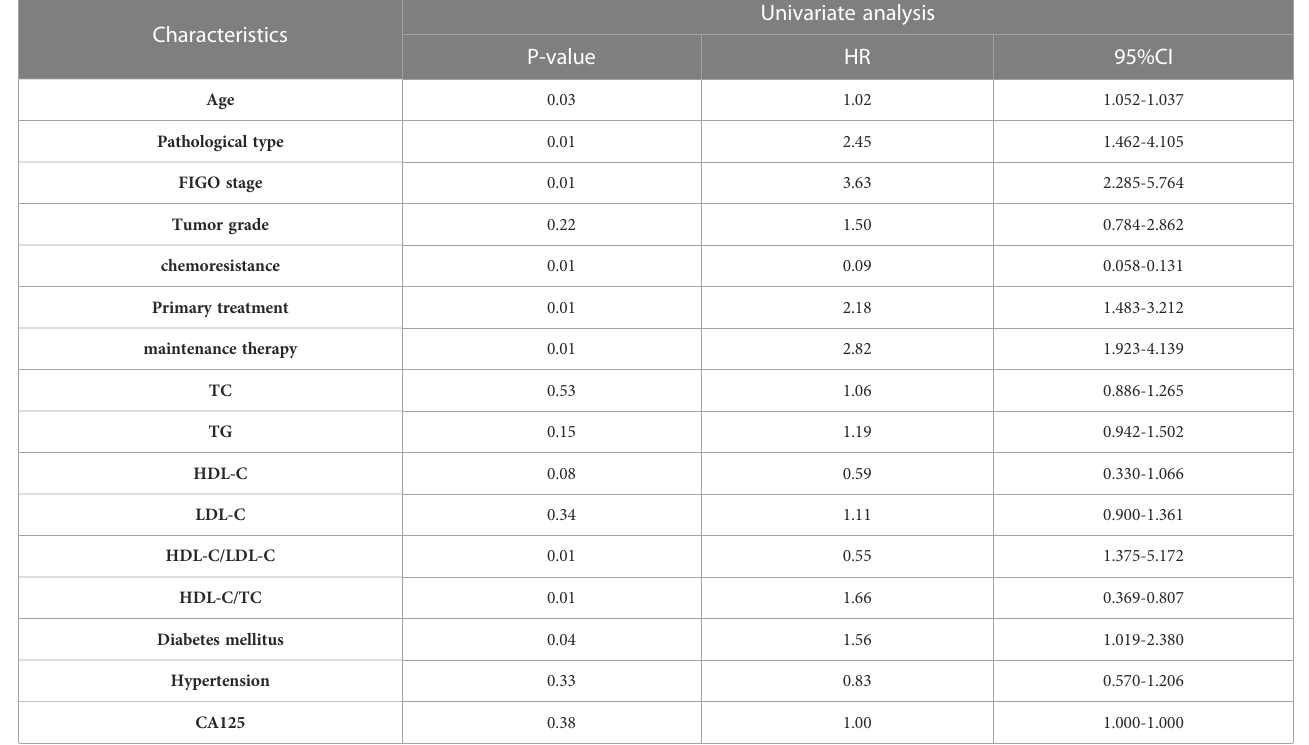
TABLE 2 Univariate survival analysis of FPS in 249 patients with ovarian